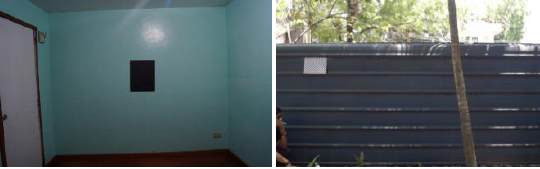
Figure 1. Study area for indoor environment (left) and outdoor environment